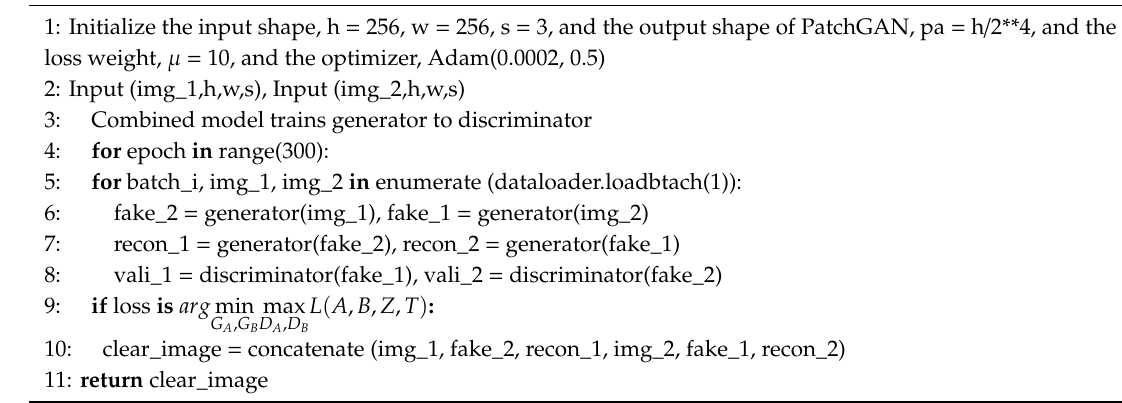
Algorithm 1: The algorithm flow of this model.